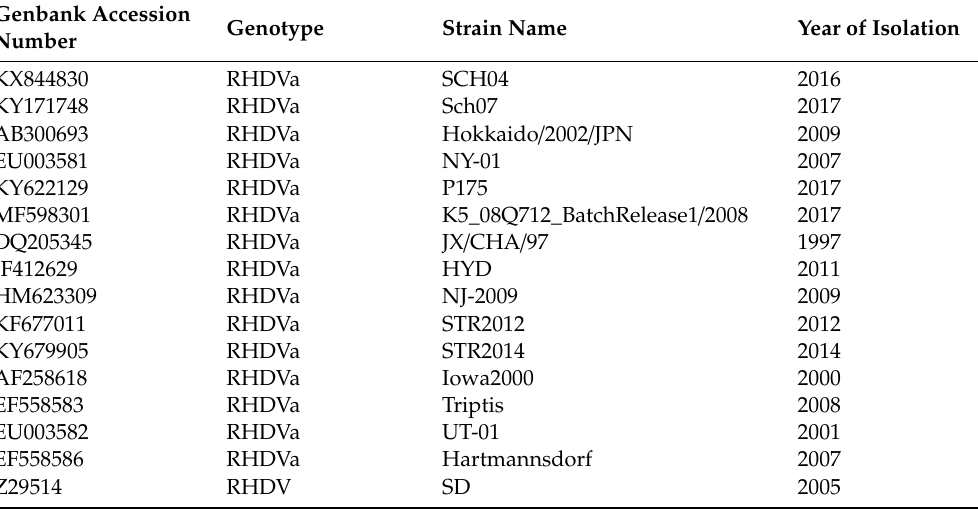
Table 2. Selected RHDV sequences to construct a phylogenetic